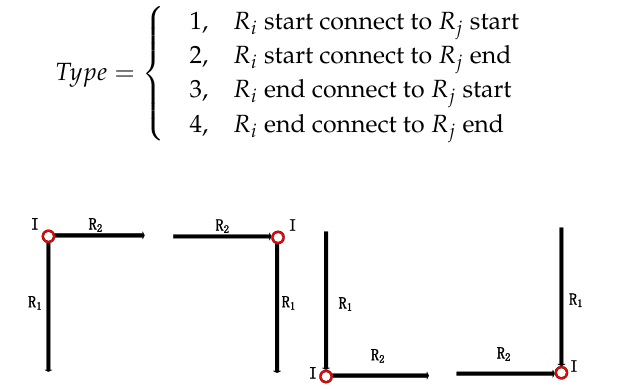
Figure 6. Four kinds of connection type defined in this paper. R represents a road segment, and I represents a connection.